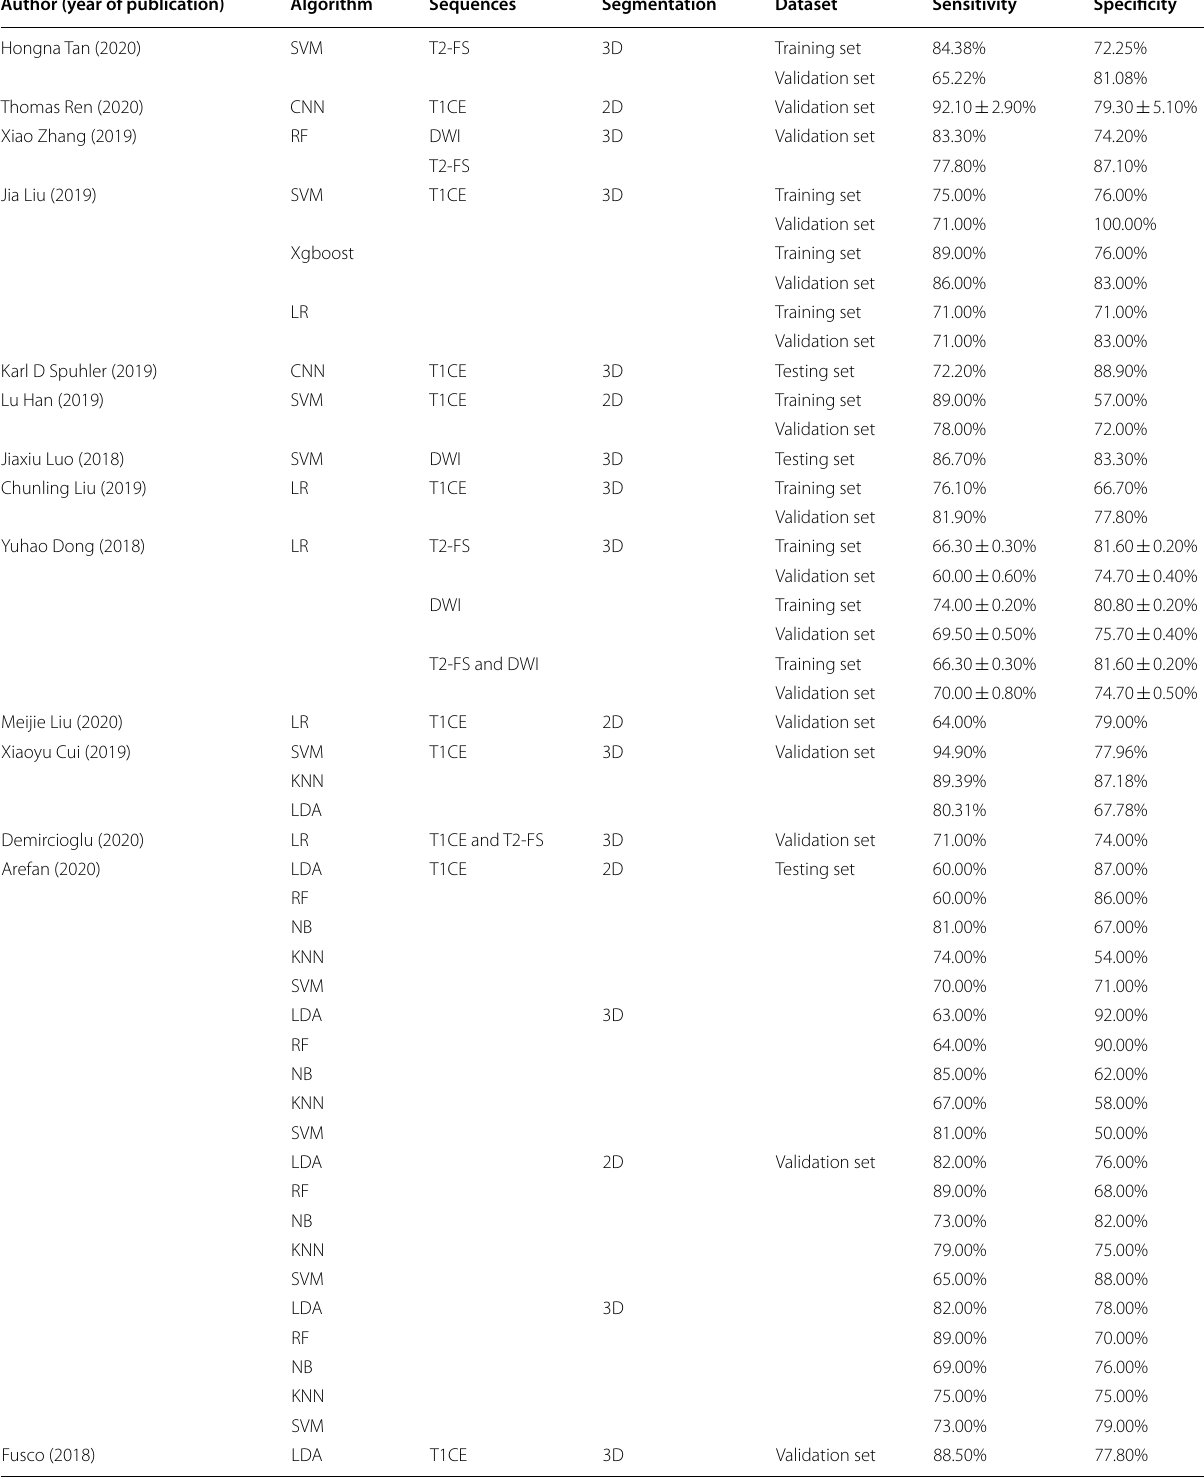
Table 2 Baseline characteristics of the included